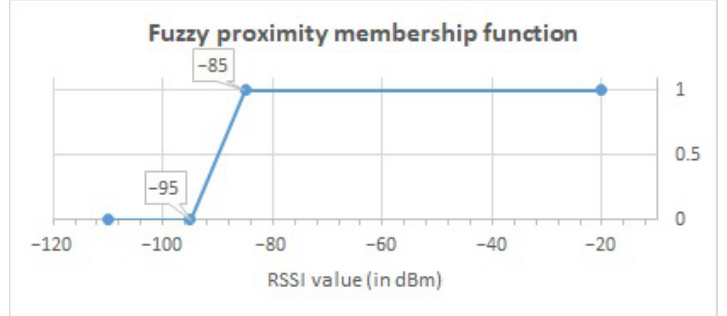
Figure 3. Trapezoidal membership functions for proximity